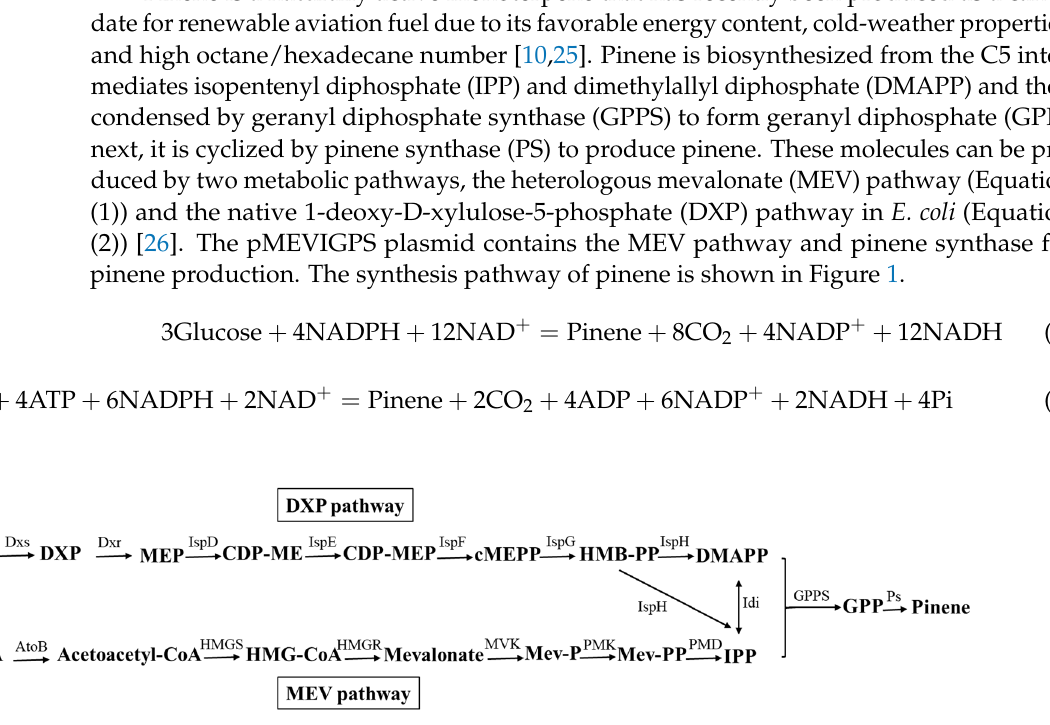
Figure 1. Schematic diagram of the synthesis pathway of pinene. G3P: glyceraldehyde 3 ‐ phosphate; Dxs: DXP synthase; DXP: 1 ‐ deoxy ‐ D ‐ xylulose ‐ 5 ‐ phosphate; Dxr: 1 ‐ deoxy ‐ D ‐ xylulose 5 ‐ phosphate reductoisomerase; MEP: 2 ‐ C ‐ methyl ‐ D ‐ erythritol ‐ 4 ‐ phosphate; IspD: 2 ‐ C ‐ methyl ‐ D ‐ erythritol 4